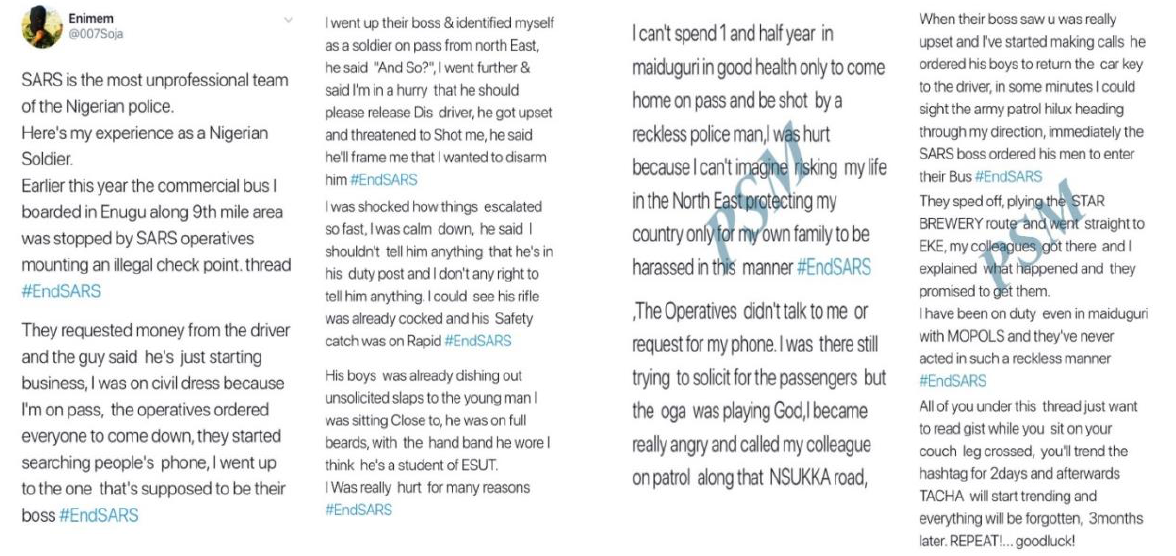
Figure 1: Account of bus incident; Source: King,